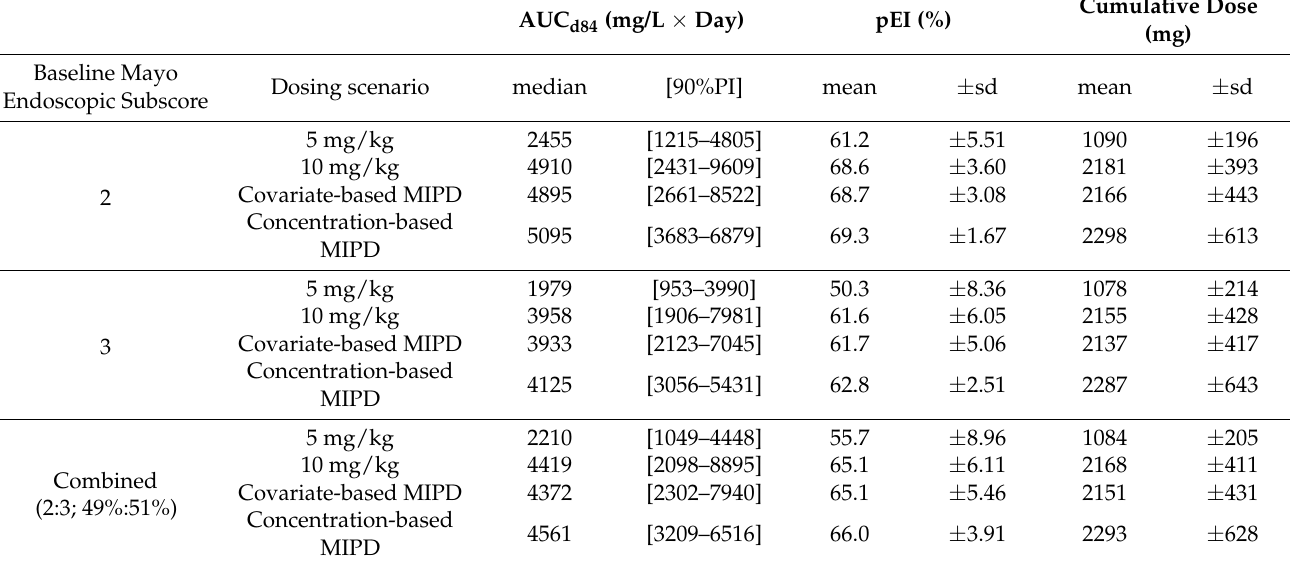
Table 1. Summary of the simulation